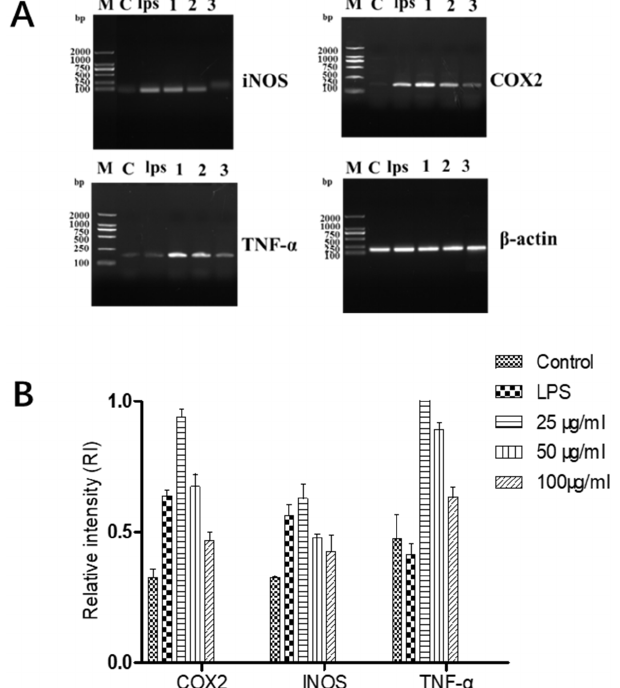
Figure 5. Effects of different concentrations of GF:OA = 1:9 on the genes’ expression of COX2, INOS and TNF in NF- κ B signaling pathway in LPS-induced RAW 264.7 cells. Cells were pretreated with TFE (50, 100, and 200 µg/mL) for 1 h, followed by LPS (1 µg/mL) stimulation for 18 h ( A ). Values represent the mean ± SD of the three independent experiments ( ∗∗ compared with LPS, and ∗∗ /##P ≤ 0 01) ( B ).